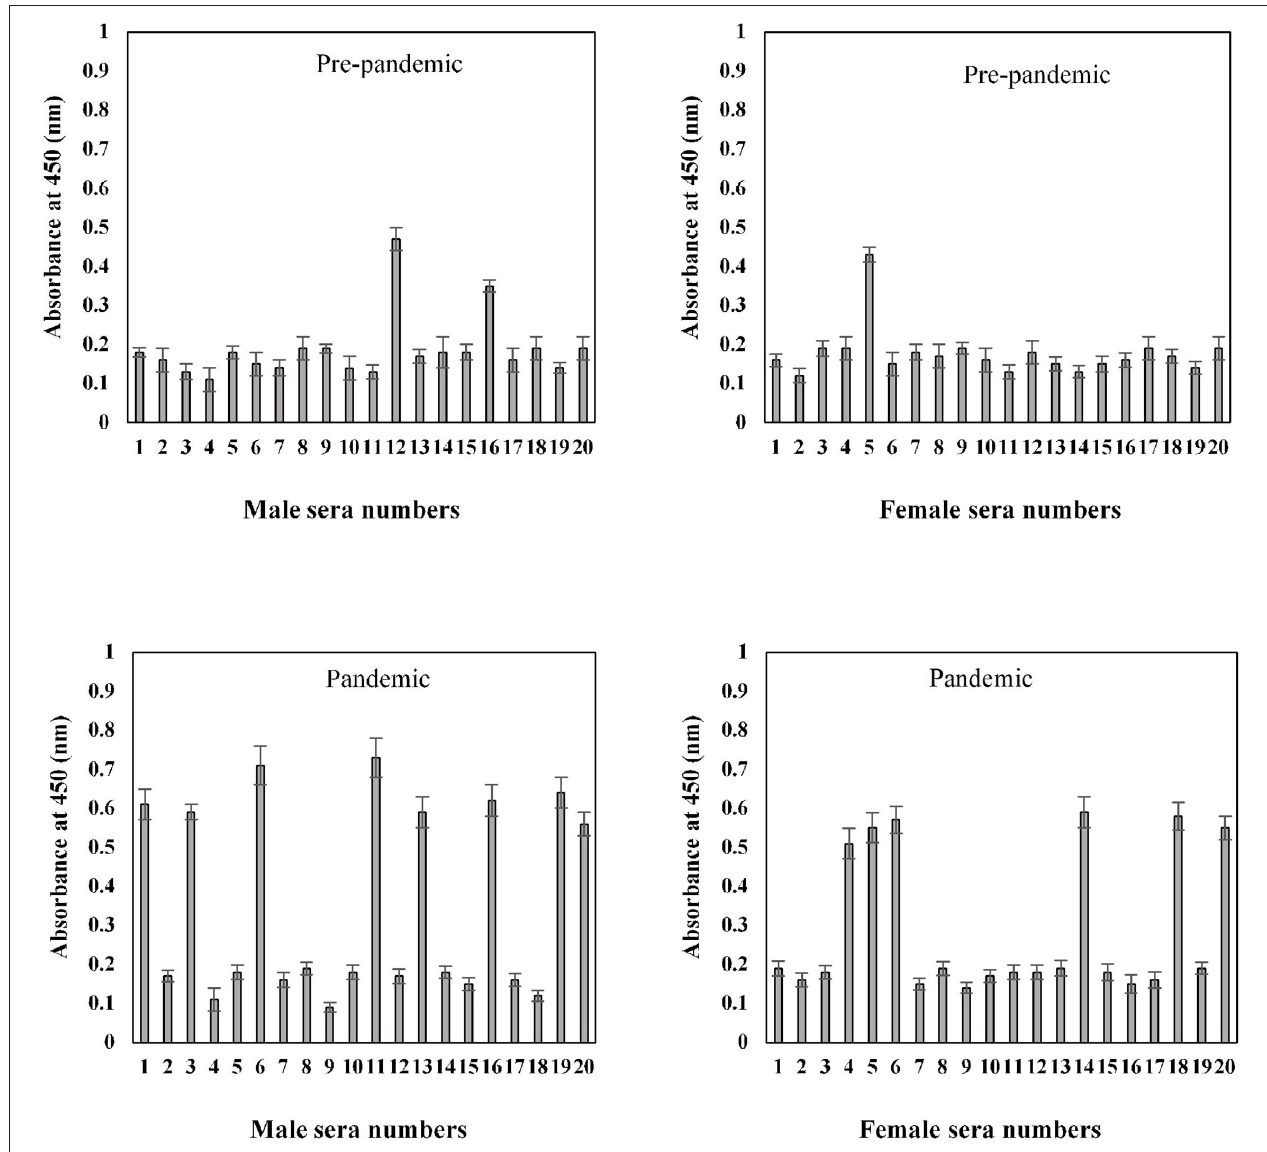
FIGURE 8 | Indirect binding ELISA from samples collected pre-pandemic and during the pandemic from men and women aged 41–60 years. ELISA plates were coated with an antigen concentration of 2 µ g/ml. Each sample was run in triplicate under similar